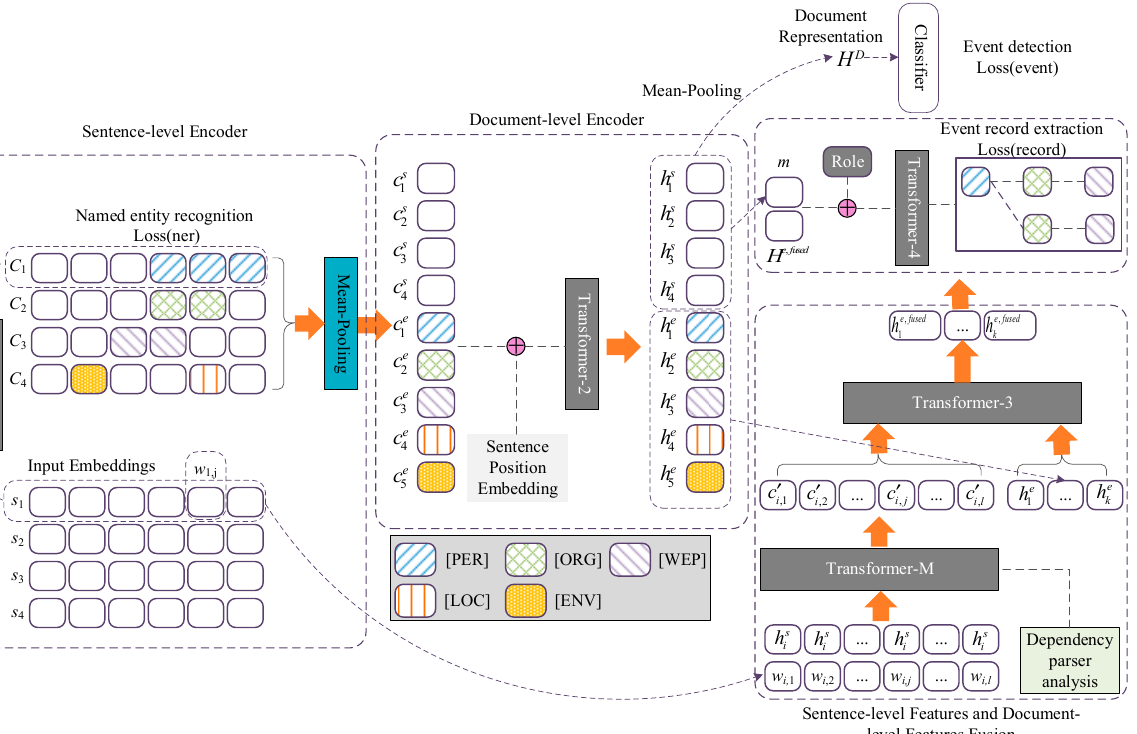
Figure 2. DEEDP model overview. For a given document, we first conduct NER with the sentence- level encoder. Then we feed the sentence-aware representations of entities and sentences of the input document to the document-level encoder to acquire their document-aware representations. To aggre- gate both representations for each entity and enhance their semantic, we designed a Transformer-M and stacked it with a Transformer. Finally, the fused representations of entities and document- aware representations of sentences are fed into the event record extraction module for event record